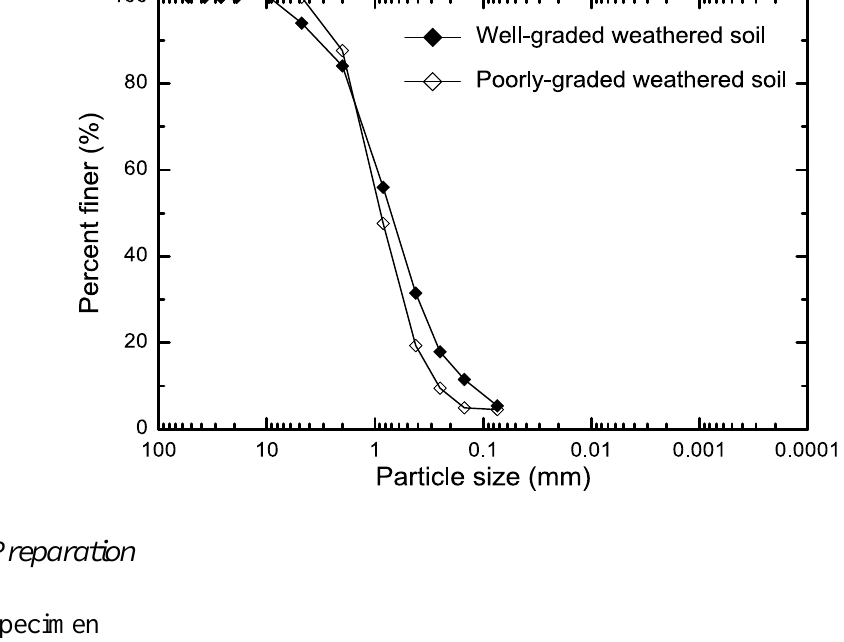
Figure 2. Soil particle size distributions of poorly-graded and well-graded weathered